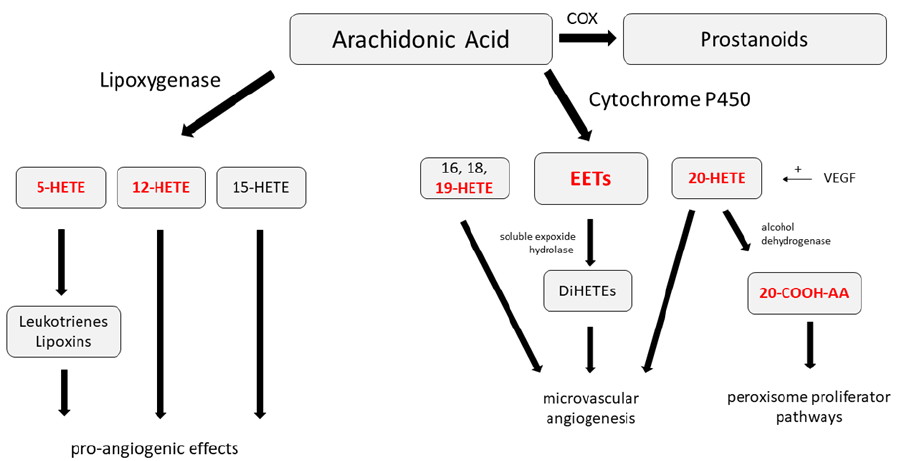
Figure 1. A schematic of arachidonic acid’s hydroxyeicosatetraenoic (HETE), and epoxyeicosatrienoic acid (EET) derivatives and their relationships. HETEs are created by both the lipoxygenase (5-HETE, 12-HETE, 15-HETE) and cytochrome P450 (16-HETE, 18-HETE, 19-HETE, 20-HETE) pathways with dihydroxyeicosatraenoic acid (DiHETE) derived from EET by soluble expoxide hydrolase. 20- carboxy-arachidonic acid (20-COOH-AA) is a metabolite of 20-HETE. Eicosanoids that were significantly different in the vitreous of control and PDR eyes in the current study are shown in bold font COX = cyclooxygenase. HETEs and their derivatives have a role in pro-angiogenic processes [17–